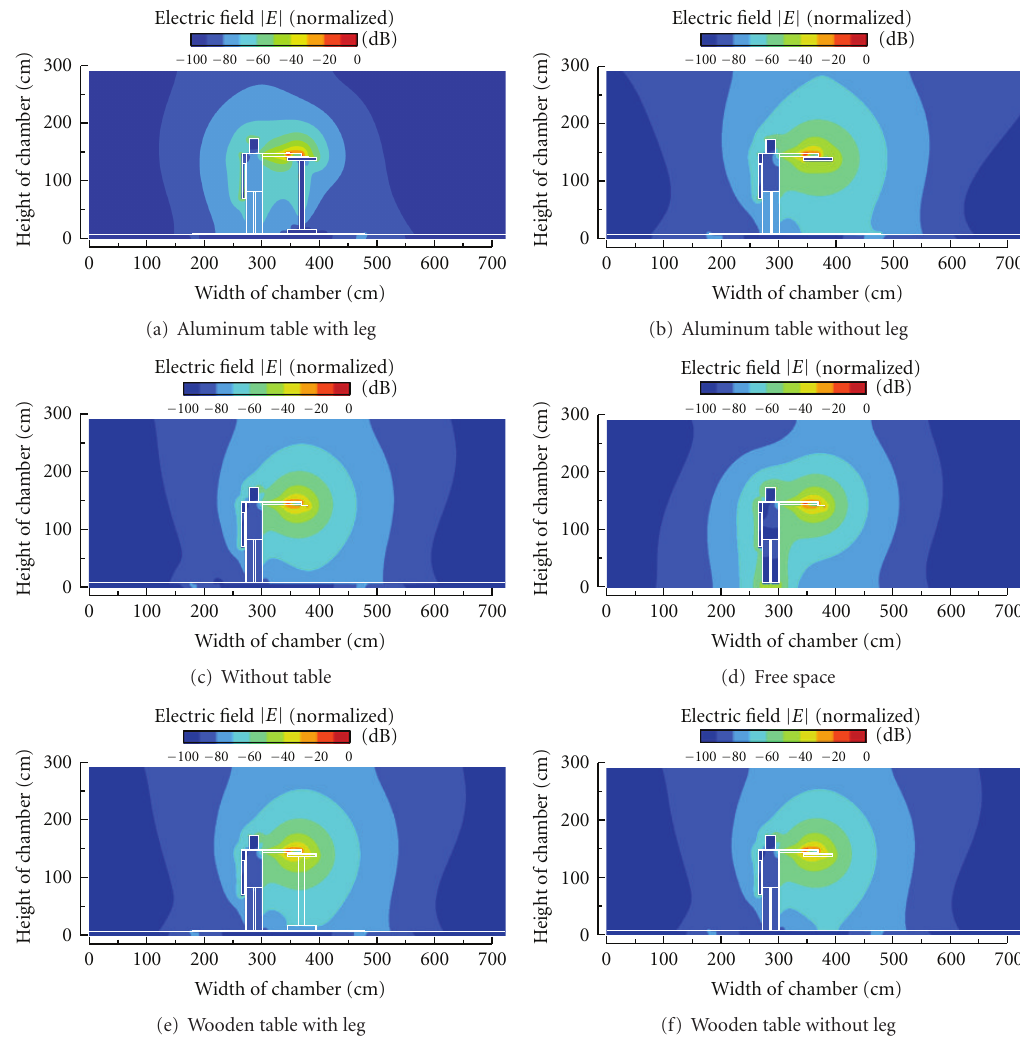
Figure 11: Electric field